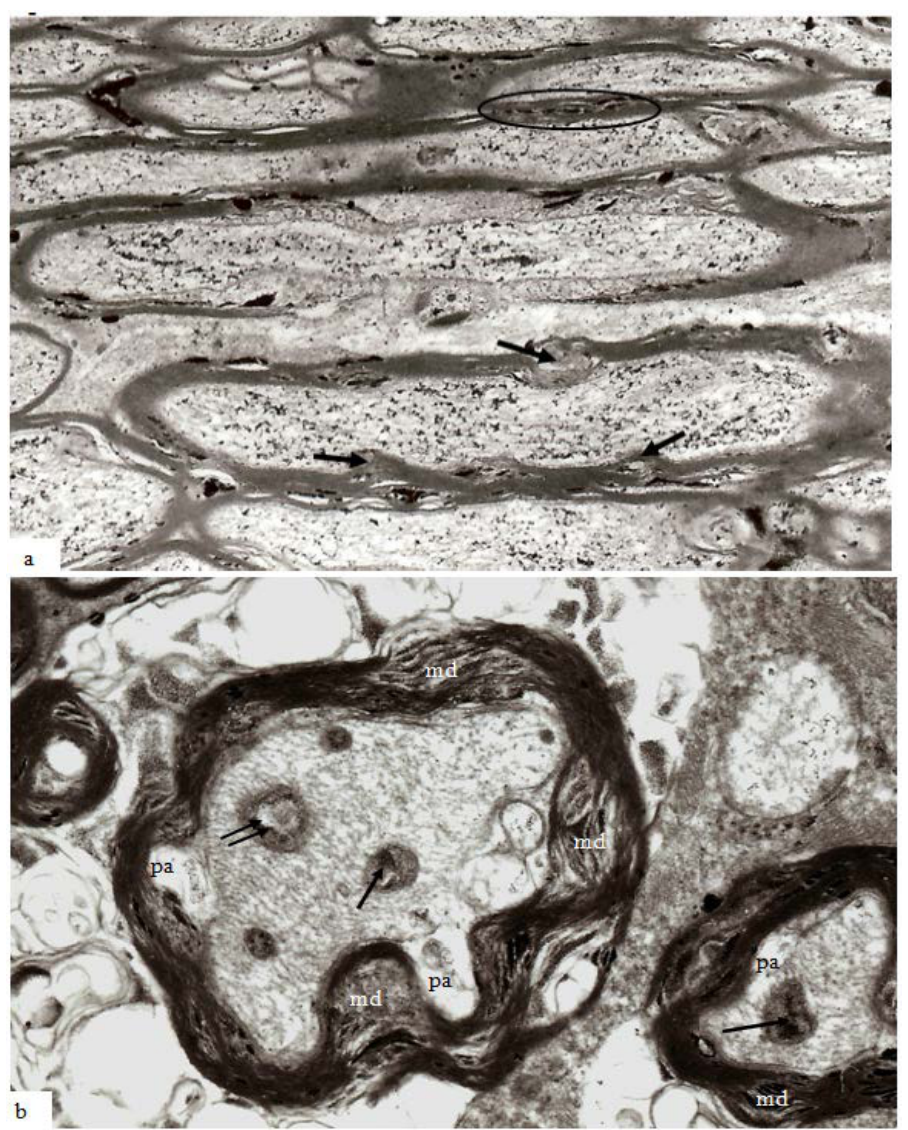
Figure 8. Thin sections of stretch-injured optic nerve at 12 h survival. Tissue was processed using the pyroantimonate technique. ( a ) At lower magification of longitudinal/ oblique sections of nerve fibers nodal structure appears normal (center) except for some disruption of the paranodal myelin. In the larger caliber nerve fibers, however, mds now extend either inside (myelin intrusions, mi) or outside (external protrusions, ep) the thickness of the myelin sheath and contain pyroantimonate precipitate. Myelin discontinuities/intrusions/extrusions are more numerous in larger than in the smaller fibers (within the oval profile above the node of Ranvier). The greater circumferential disruption formed by md, mp and me is obvious in transverse sections of nerve fibers ( b ) and are more numerous and extensive within the myelin sheath of larger fibers. The axons have an irregular cross-section and a number of periaxonal spaces (pa) occur between the axon and the myelin sheath. Mitochondria within the axoplasm either contain aggregates of pyroantimonate precipitate (arrow) or have a central lacuna (double arrow). The axoplasm of the nerve fibers contains closely spaced microtubules and neurofilaments which form spiral arrays. Magnification ( a ) 7500×; ( b )